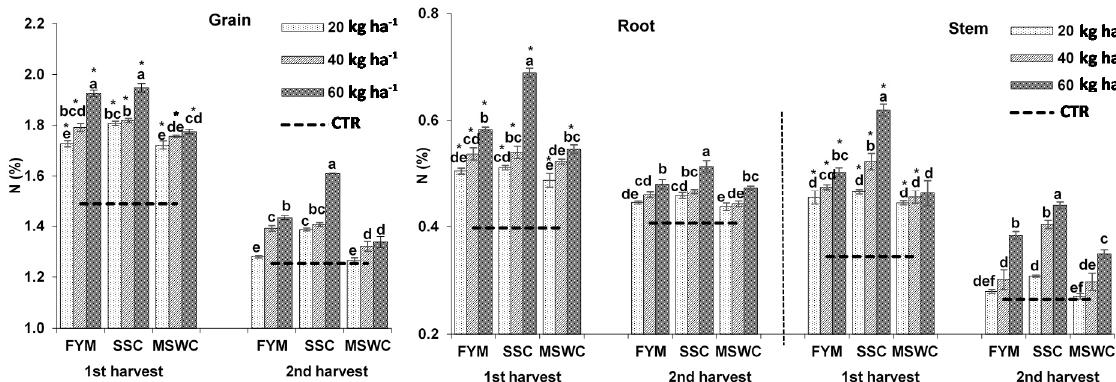
Figure 6. Effects of the soil amendment with different doses (20, 40, 60 t ha − 1 ) of farmyard manure (FYM), sewage sludge compost (SSC) or municipal solid waste compost (MSWC) on N contents in barley grains, stems and roots. CTR: unamended soil. Lower case letters indicate significant differences between treatments within the same harvest time. Asterisks indicate significant differences between harvest time within each treatment over time (* p < 0.05).